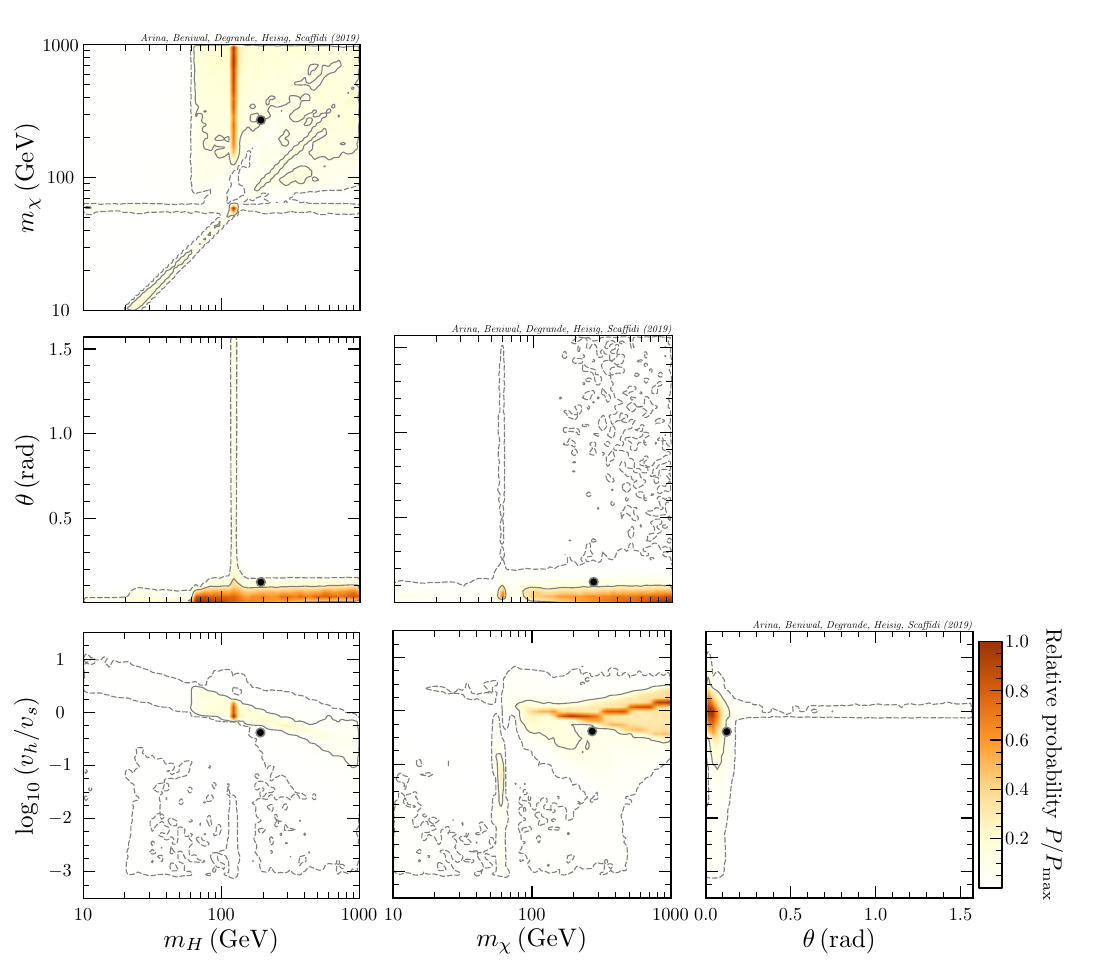
Figure 4 . 2D marginalised posterior (MP) distributions in planes of the pNG DM model param- eters. The 1 (cid:27) (2 (cid:27) ) credible intervals are marked by solid (dashed) lines. The posterior mean is shown as a black